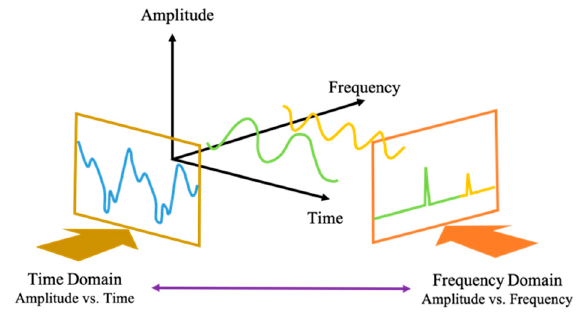
Figure 7. Component of breathing waveform.